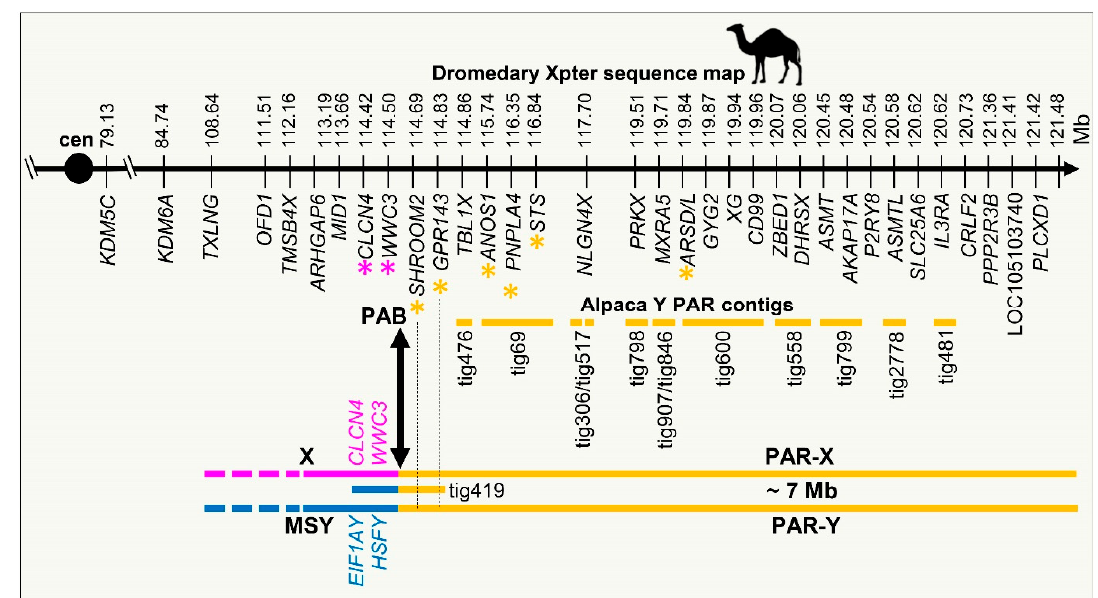
Figure 5. Reconstruction of the PAR in both sex chromosomes. The sequence map of the terminal region of dromedary Xp (Xpter) is presented at the top; orange horizontal lines denote PAR-X, PAR-Y, and alpaca Y PAR contigs; the location of PAB proximal to SHROOM2 is denoted with a black arrow; purple lines and fonts denote X-specific sequences and genes, and blue lines and fonts Y-specific sequences and genes; gene symbols with a star (*) denote the genes that have been mapped to alpaca and dromedary PAR by FISH [56].